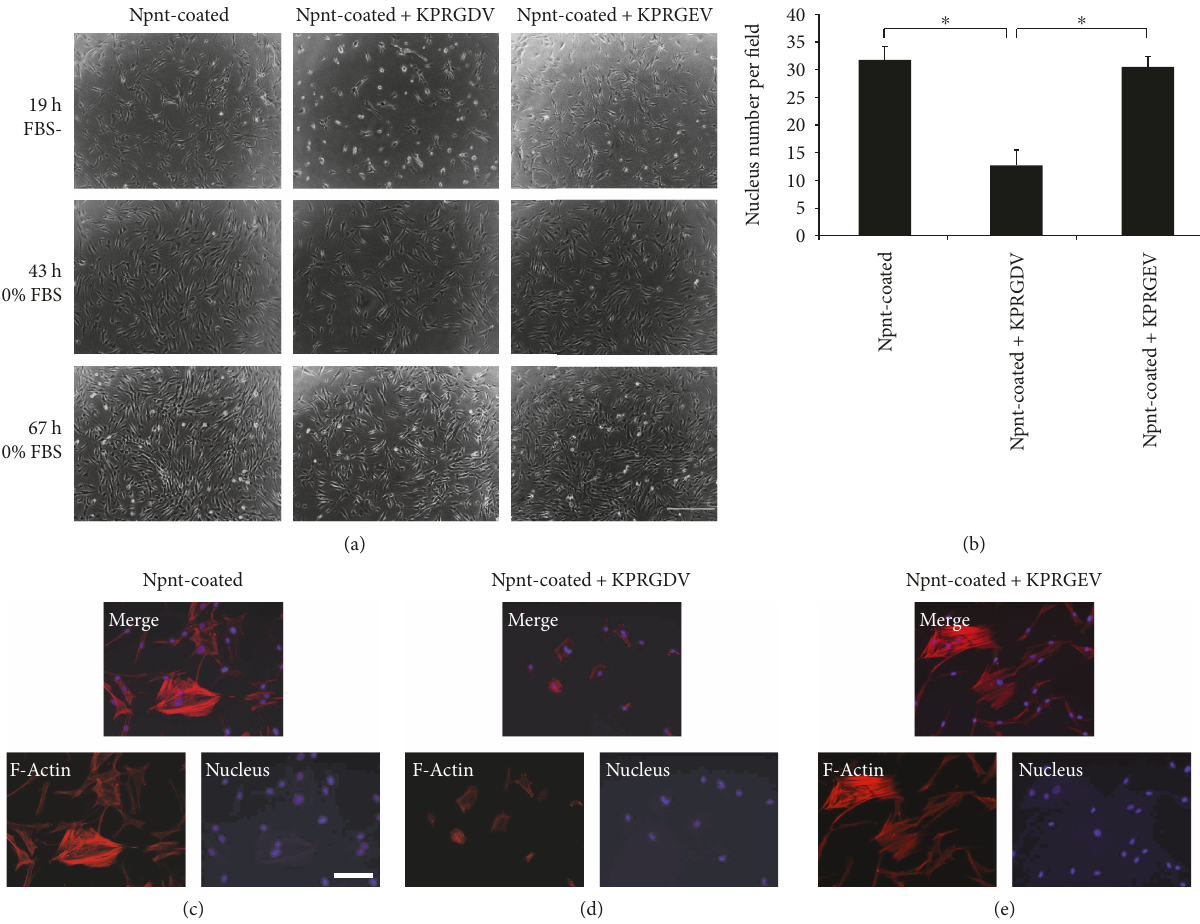
Figure 5: RGD was the key peptide that allowed hDPSCs to bind with Npnt. (a) hDPSCs (passage number 5) were treated with KPRGDV (1 mM in PBS) (a, middle), KPRGEV (1 mM in PBS) (a, right), or equal volume of PBS (Control) (a, left) for 10 min and were then seeded onto Npnt (10 μ g/mL)-coated substrate(s) (24-well plate) in serum-free DMEM, and media were changed into FBS (10%) containing DMEM after 19 h. Scrambled peptide (KPRGEV) did not inhibit cell adhesion (a, 19h right). KPRGDV abrogated cell adhesion and spreading (a, 19h middle). The abrogation was reversible when serum-free DMEM was replaced with 10% FBS containing DMEM (a, 43 h and 67 h) (scale bar: 400 μ m). (b) Nucleus number determination in four separate fi elds under microscopy for each group. ∗ p < 0 01 by post hoc Tukey ’ HSD test. (c) hDPSCs were fi rst treated with PBS (c), KPRGDV (d), and KPRGEV (e) and subsequently seeded into Npnt-coated substrate(s) in serum-free DMEM for 24 h. Fluorescence staining was conducted to visualize actin stress fi bers and nucleus. Well-development actin stress fi bers were observed in (c) and (e), whereas cells remain round in (d) (scale bar: 100 μ